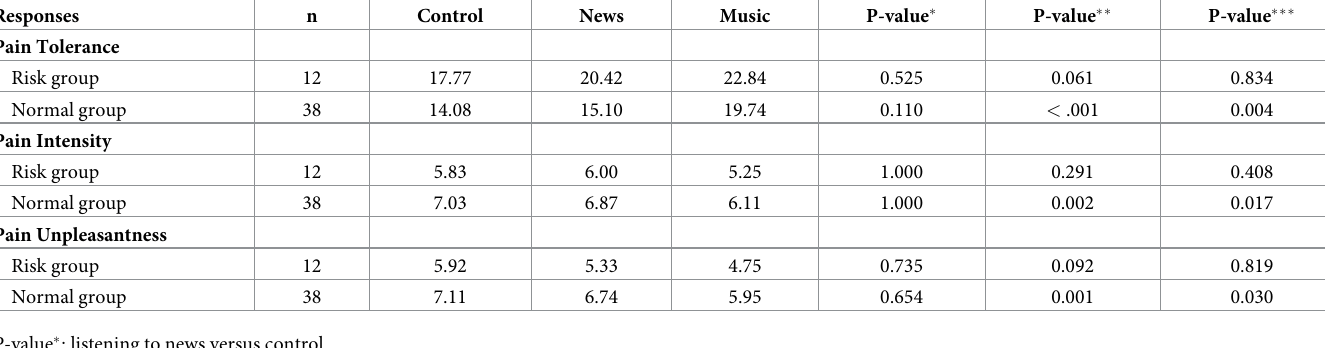
evaluated the psychometric properties of ASI-16 scores and suggested the possible classifica- tion that those with less than 21 on the ASI-16 were categorized into the “normal” group, and those with a score higher than or equal to 21 were categorized into the “risk” group. Table 4 shows results of the Pairwise tests for pain responses during the music, the news, and control condition. Pain responses during the music condition for the “normal” group differed significantly from the news (PT, p < .001; PI, p = .002; PU, p < .001) and control conditions (PT, p = .004; PI, p = .017; PU, p = .030) in that PT was higher, and PI and PU were lower. This was not the case for the risk group. Finally, we investigated the relationship between pain responses and individual differences in pain anxiety symptoms. The PASS-20 (20 item Pain Anxiety Symptoms Scale) is the most widely used measure of pain-related anxiety construct and McCracken and Dhingra [35] developed it, with responses ranging 0 (never) to 5 (always). Abrams et al. [36] evaluated the psychometric properties of PASS-20 scores and suggested the possible classification that those with less than and equal to 25 on the PASS-20 were categorized into the “normal” group, and those with a score higher than 25 were categorized into the “risk” group. Table 5 shows that pain responses during the music condition for the normal group differed significantly from control condition, with PT being higher (p < .001), and PI and PU being lower (p = .001 and p < .001, respectively). However, results of pain responses during the music condition did not differ from the news condition (PT, p < .001; PI, p = .115; PU, p = .180). There were no consis- tent results for the risk group in pain anxiety symptoms when the music condition was com- pared the news and control condition. Table 4. Pairwise tests for comparing pain responses between treatments for those low and high on the ASI-16. Responses